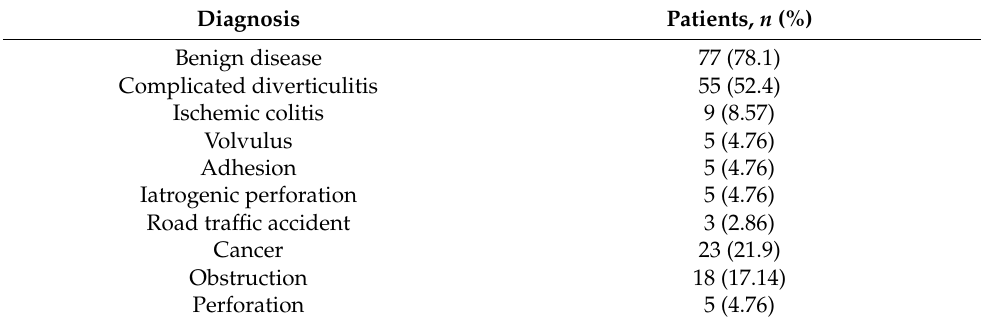
Table 1. Indications for emergency HP in patients with left side colorectal